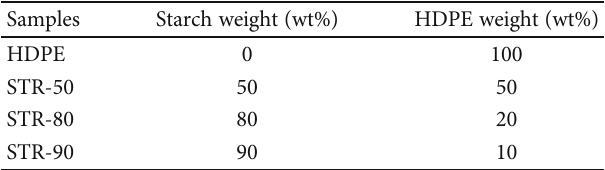
Table 1: Composition of starch-based composite fi bers.